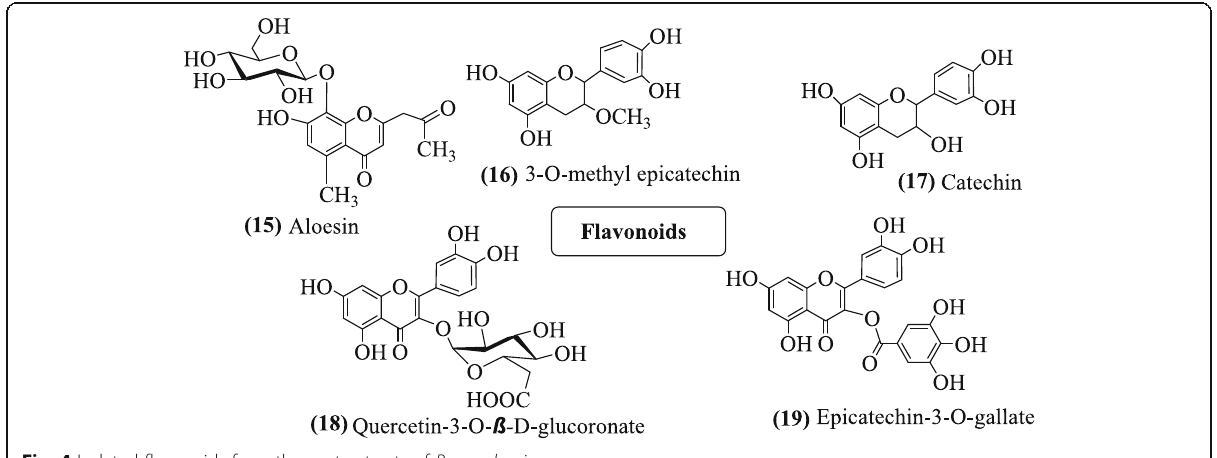
Fig. 4 Isolated flavonoids from the root extracts of R. nepalensis